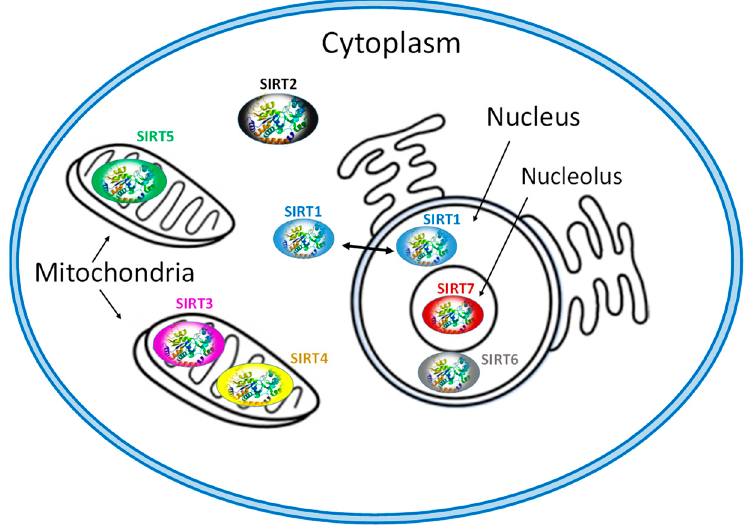
Figure 1. Subcellular location of seven mammalian SIRTS (SIRT1-7).